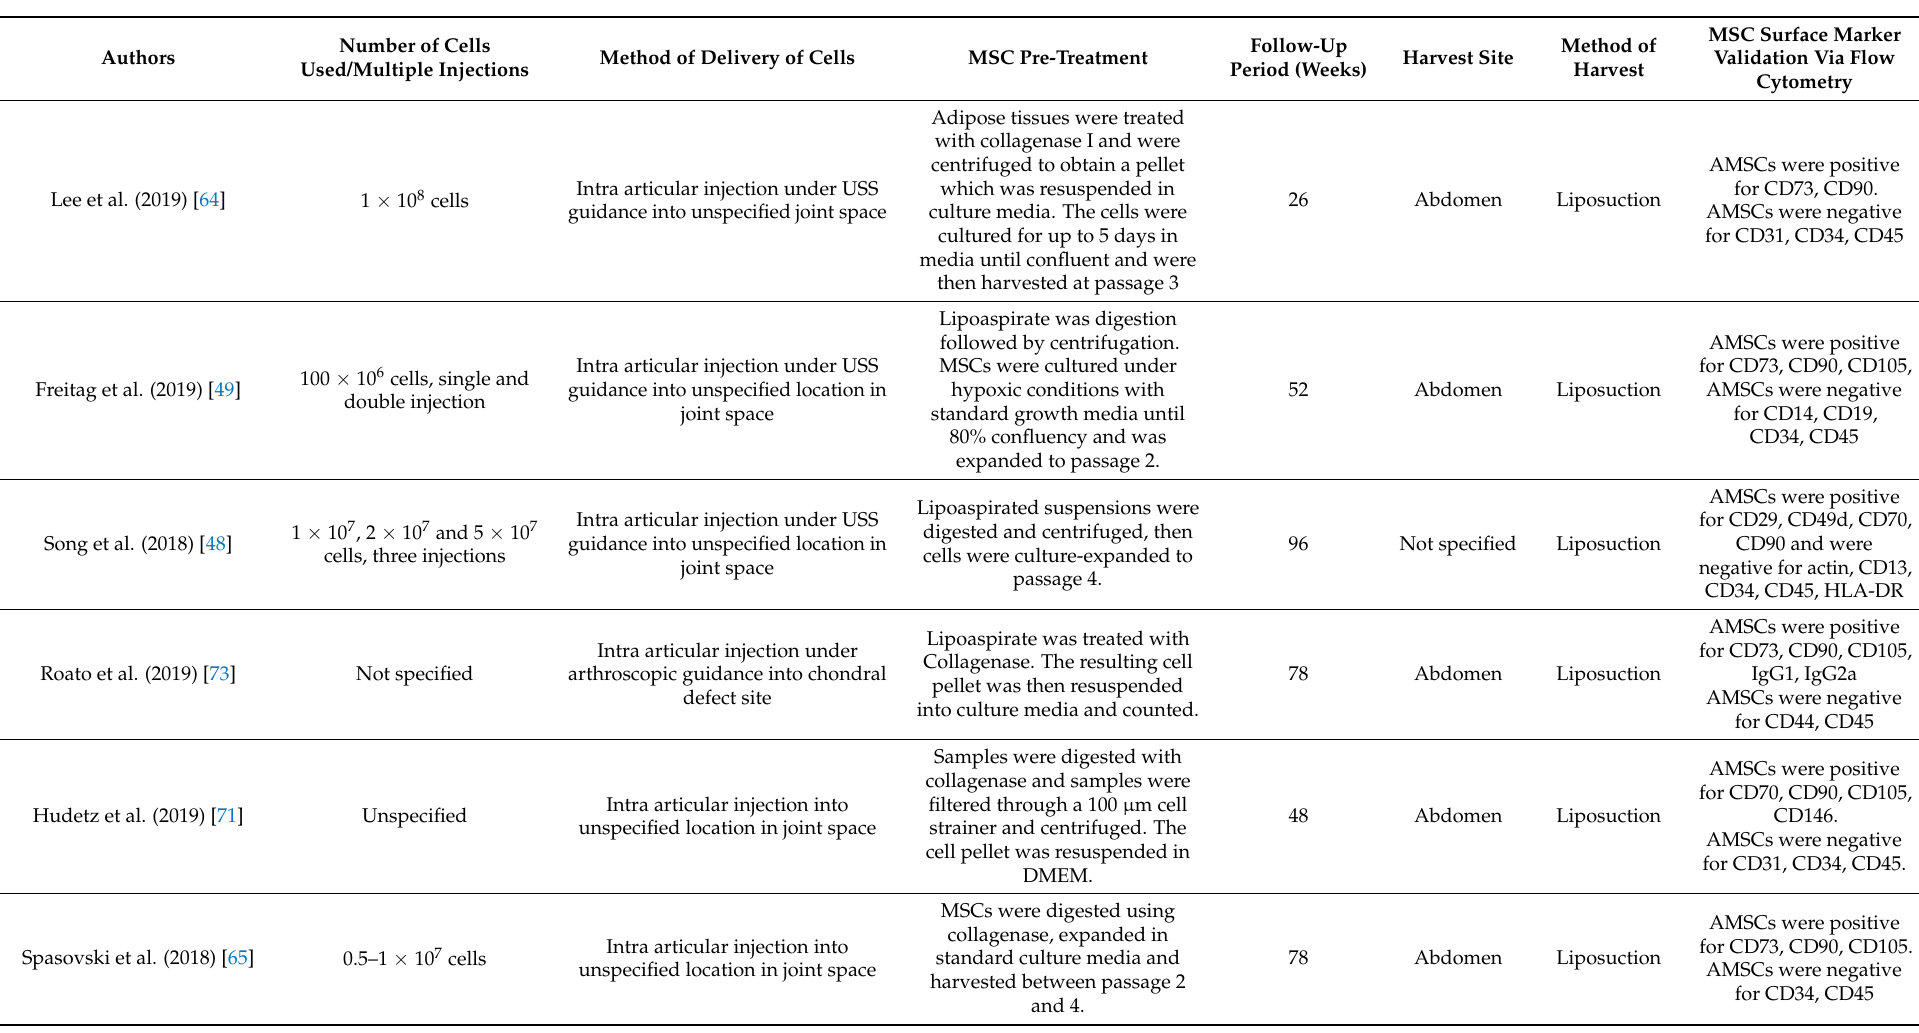
Table 3. Cellular characteristics for AMSC studies, n =